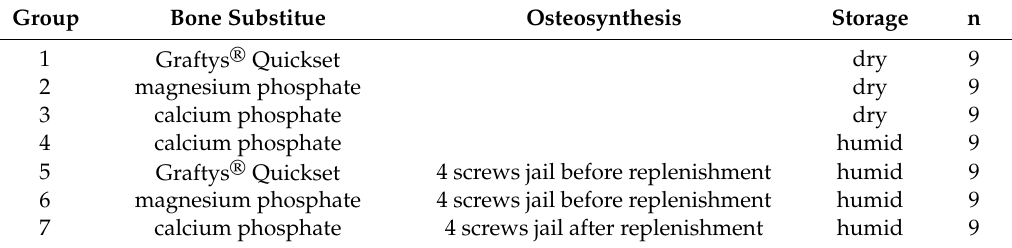
Figure 2. Fracture simulation, reduction, and additional screw osteosynthesis. Workflow of specimen preparation for the fracture model: Five determined breaking points ( a ) for the indenter ( b ) were set on the lateral tibial plateau to produce a pure impression fracture ( c ). After placing a K-wire under the depressed fragment ( d ), the lateral corticalis was opened with a drill ( e ), enabling placement of a cannulated ram ( f ) to compact subchondral spongiosa and restore a plane joint surface ( g ). In groups 5–7, fracture stabilization was complemented with a four-screw osteosynthesis using the jail technique ( h ). Table 2. Experimental groups; display of the seven groups for biomechanical analysis of tibial head fractures using osteosynthesis techniques and storage